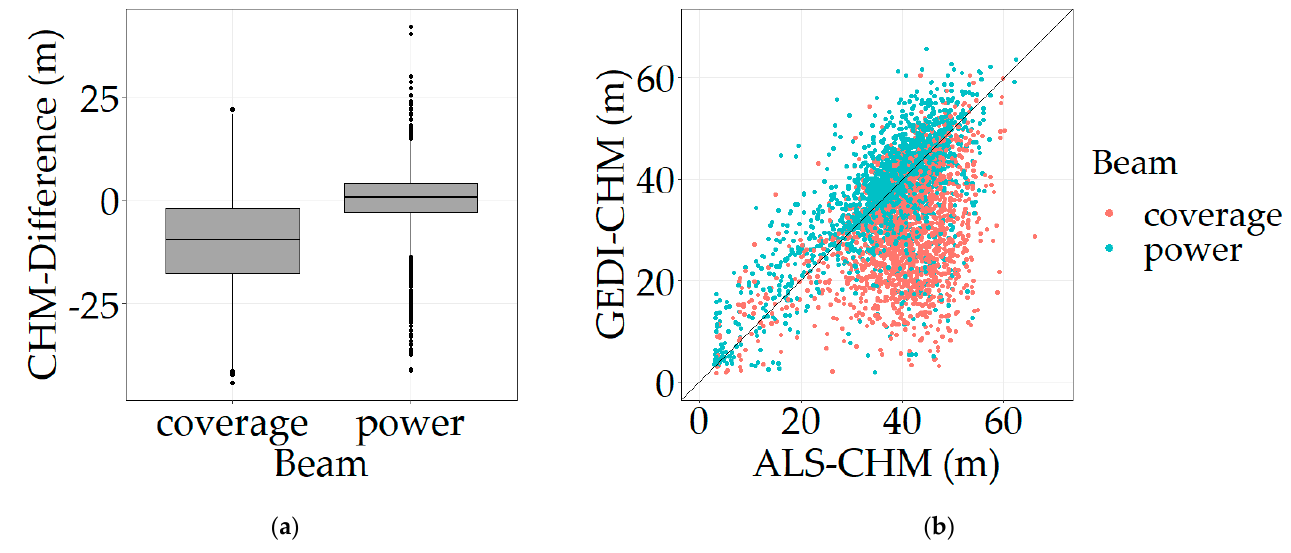
Figure 5. Boxplots of the CHM-Differences ( a ) and GEDI-CHM as a function of ALS-CHM ( b ) de- pending on beam type (algorithm setting group number 5).